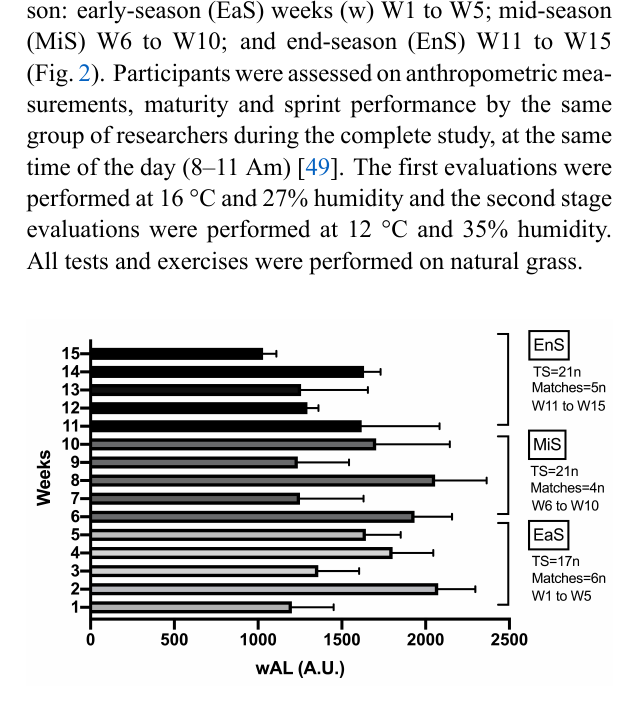
Fig. 2. Research outline of the weekly monitoring on training and match load and assessed sessions during the competition season. EaS, early-season; Mid, mid-season; EnS, end-season; wCL, weekly accumulated chronic workload; TS, training ses- sions; A.U., arbitrary